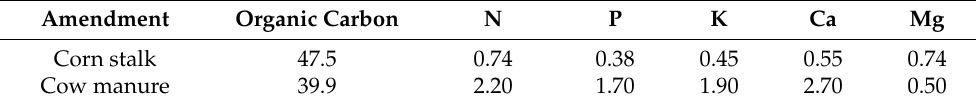
Figure 1. An overview of the plot showing ridges. Table 2. Chemical properties of corn stalk and cow manure applied in